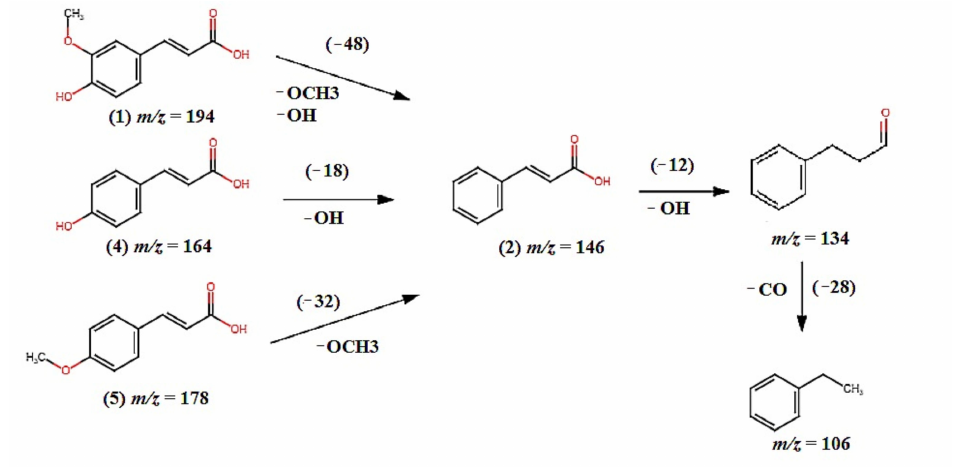
Figure 4. Fragmentation pathways for compound ferulic acid ( 1 ), cinnamic acid ( 2 ), p -coumaric acid ( 4 ), and 4-methoxycynammic acid ( 5 ).